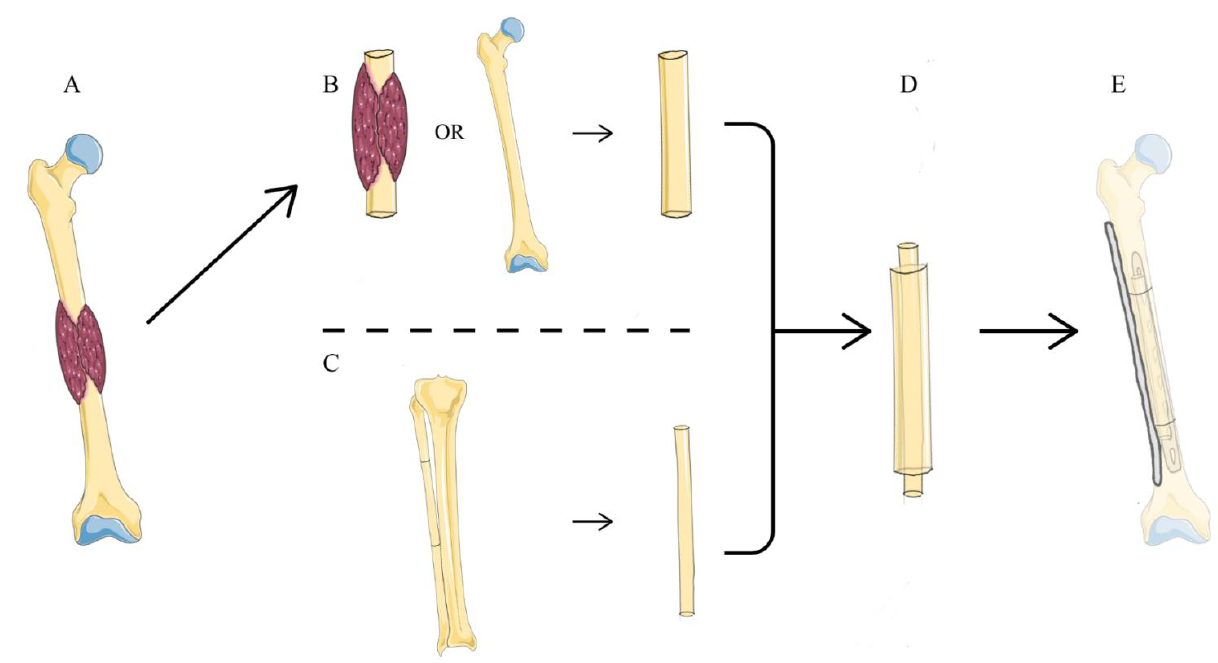
Figure 1. Diagram showing biological reconstruction methods after resection of diaphyseal bone tumor in the femur. ( A ) The tumor is located in the diaphysis of femur. ( B ) Preparation of devitalized autograft or allograft. ( C ) Preparation of the ipsilateral fibular graft. ( D ) The fibula is inserted into the intramedullary canal of devitalized autograft or allograft. ( E ) Reconstruction of the diaphyseal defects with the fibular graft using double plates for internal fixation.